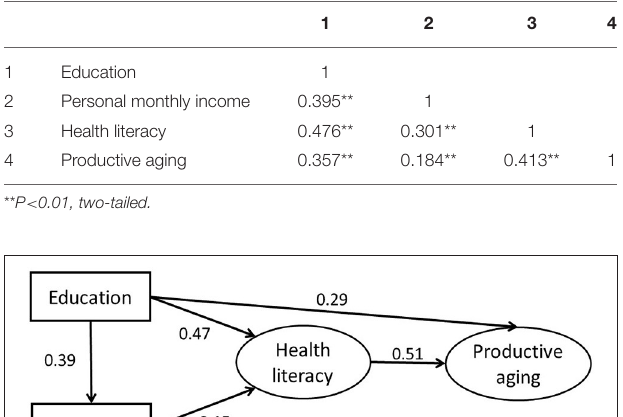
TABLE 4 | Correlation among SES, health literacy and productive aging.